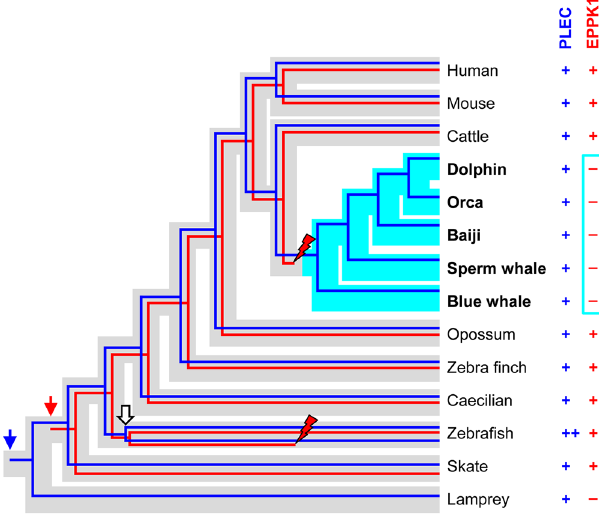
Figure 4. Schematic model of the origin and loss of EPPK1 during the evolution of vertebrates. The presence (+ , 1 gene copy; ++ , 2 gene copies) or absence (–) of intact PLEC and EPPK1 genes was used to infer the origin (vertical colored arrows) of PLEC (blue) and EPPK1 (red) genes and the loss of the capacity of EPPK1 to encode a functional plakin protein (red flash symbols) in cetaceans. The white arrow indicates a whole-genome duplication in teleosts. Phylogenetic trees of genes are shown within the species tree (grey for non-cetaceans, light blue for